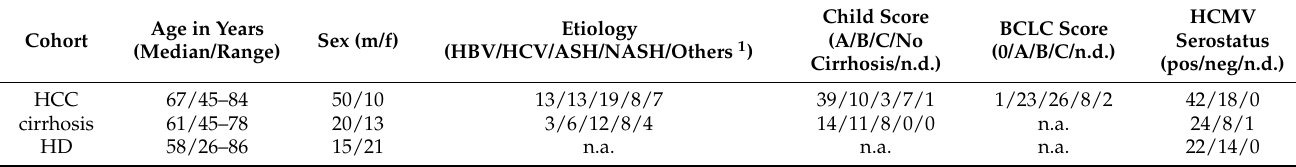
Table 1. Characteristics of the study